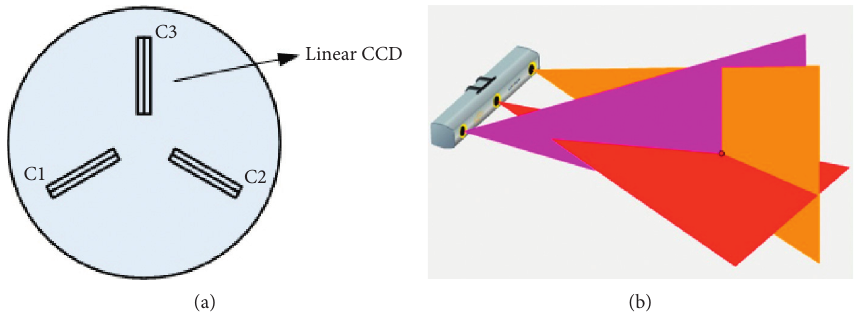
Figure 2: 3D photoelectric sensor. (a) Dynamic measurement device. (b) Spatial positioning